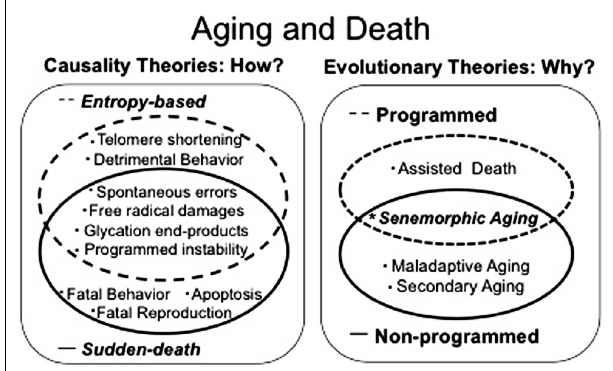
FIGURE 1 |Aging and death theories can be classified into two groups: (1) causality theories which address questions of how aging and death occur and can be subdivided into entropy-based processes and “sudden death.” (2) Evolutionary theories which try to explain why species age and die in the way they do.They consist of programmed aging, non-programmed aging and senemorphic aging which is a special case where parallel evolution of “senemorphisms” (independent aging phenotypes encoded by the genome) are related to both a genetic profile to accelerate aging and a genetic profile to maximize